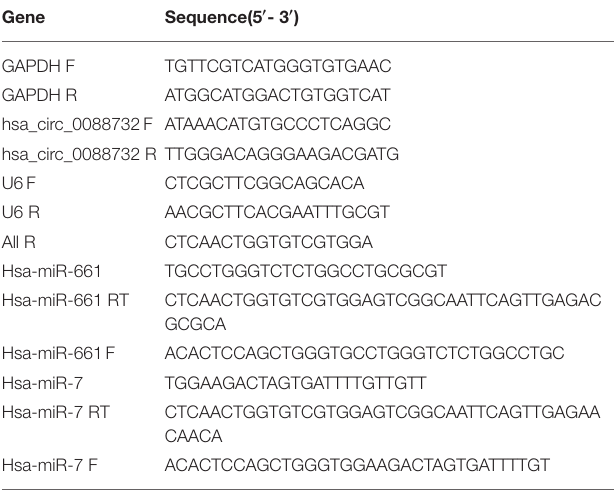
TABLE 1 | The sequences of primers used in real-time